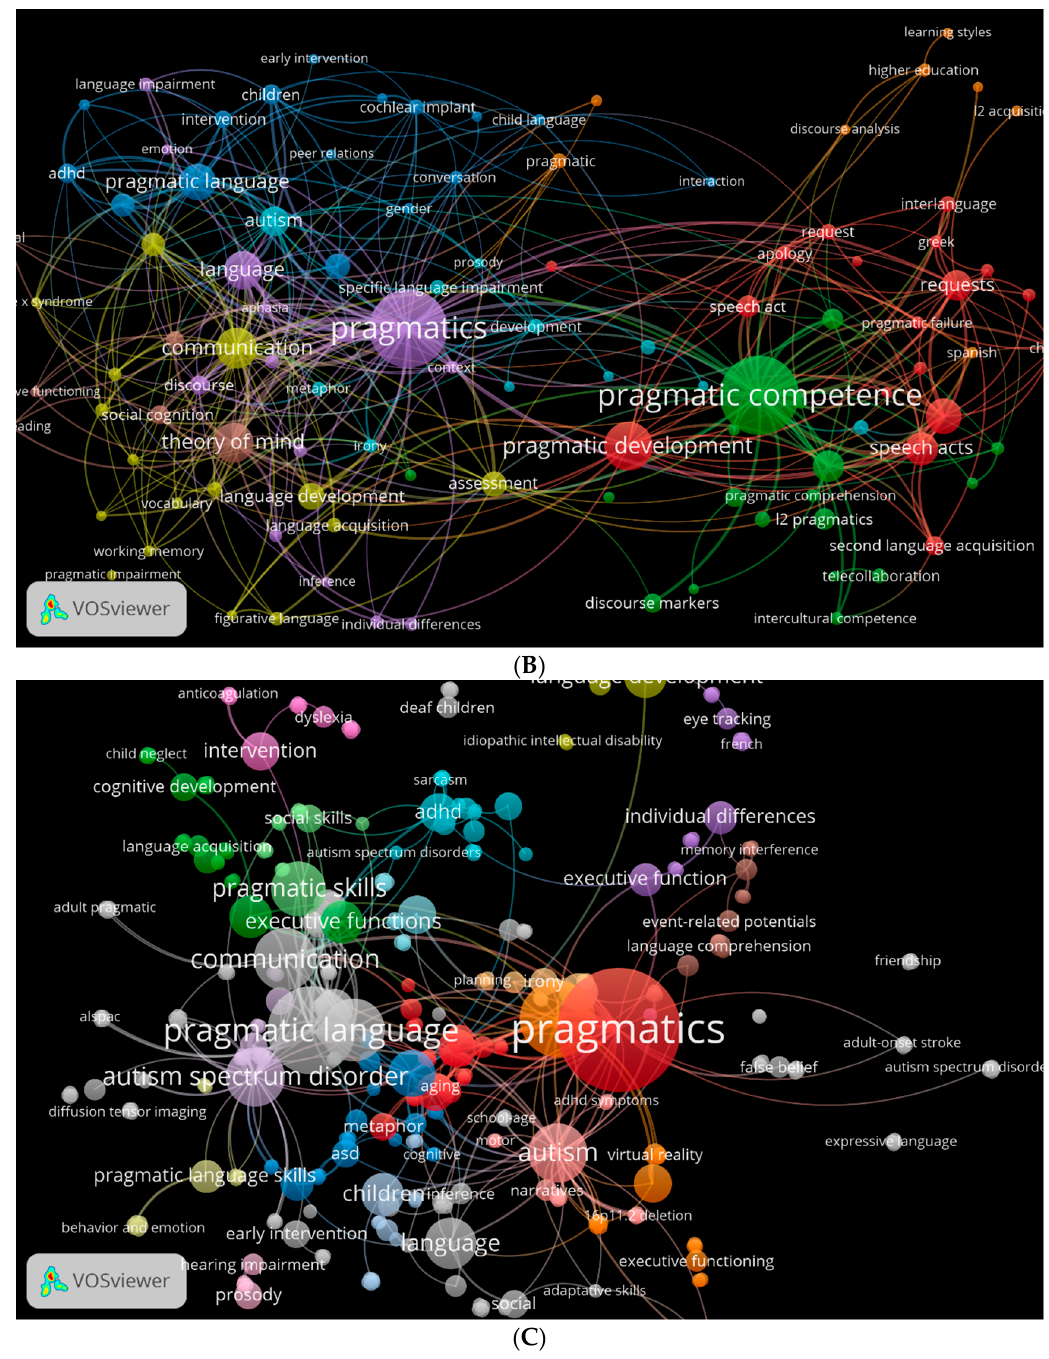
Figure 10. Network visualisation of keyword co-occurrence by author: ( A ) Scopus; ( B ) WOS; ( C ) Lens.